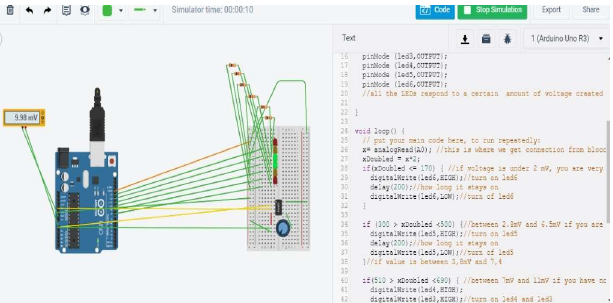
Fig: When Glucose level is normal, the LEDs 3 and